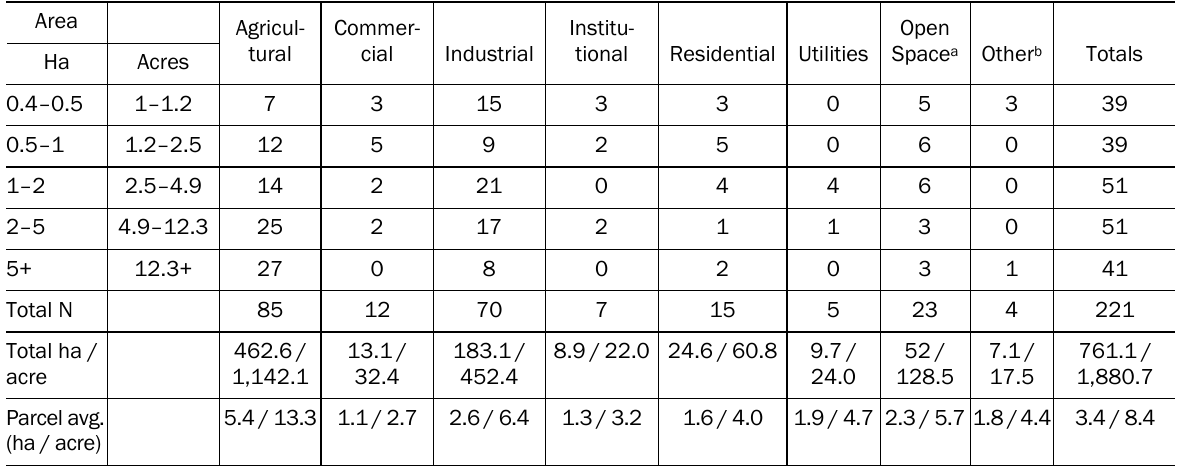
Table 2. Number of Growing Parcels in Scarborough, Organized by Zoning and Parcel Size